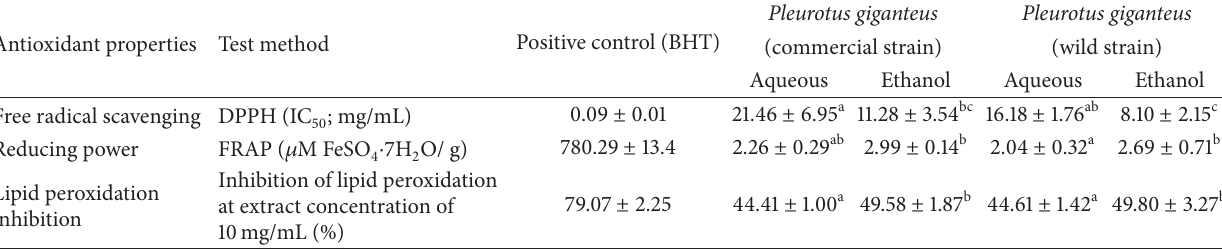
Table 5: Antioxidant activities of the aqueous and ethanol extracts from the commercial strain of Pleurotus giganteus (KLU-M 1227) and the wild strain (KLU-M